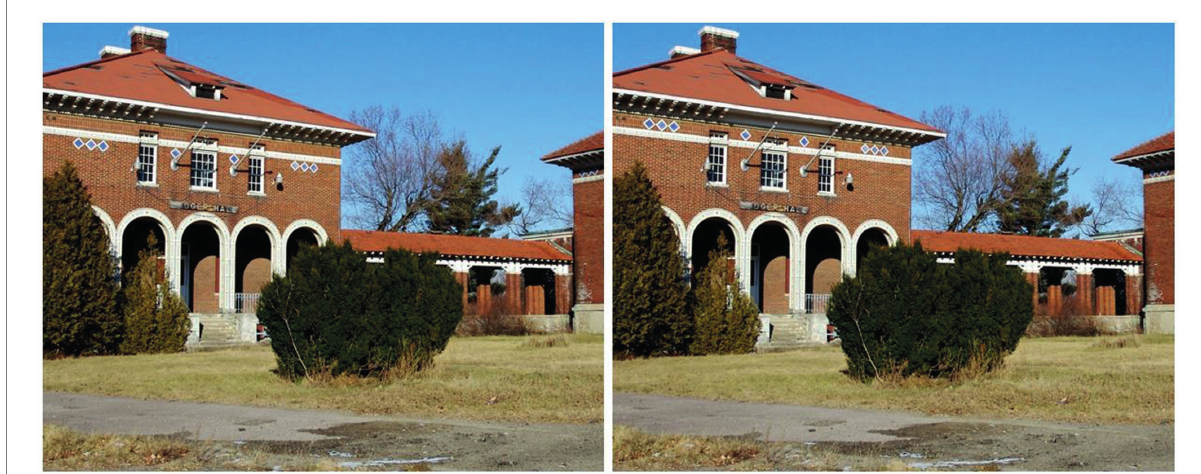
FIGURE 1 An example of image used in the change blindness task. Original image (left); Modified image (right) has diamond shapes above the white line, not